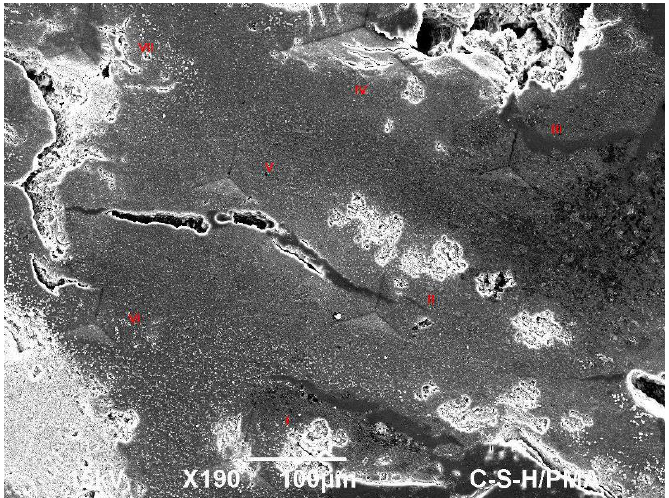
Figure 9. C-S-H/PMA SEM micrograph showing 5 indentations (matrix